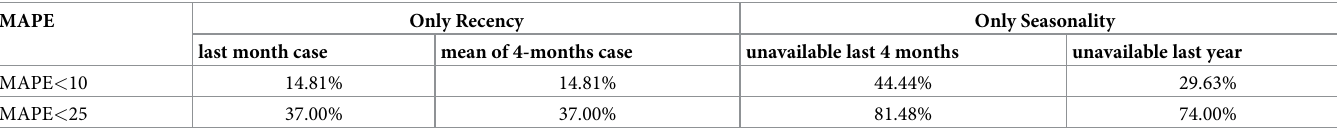
Table 11. Scarcity in seasonal historical and recent data—Evaluation of performance of recency and seasonality features in 27 Museums in U.K. MAPE Only Recency Only Seasonality last month case mean of 4-months case MAPE < 10 14.81% MAPE < 25